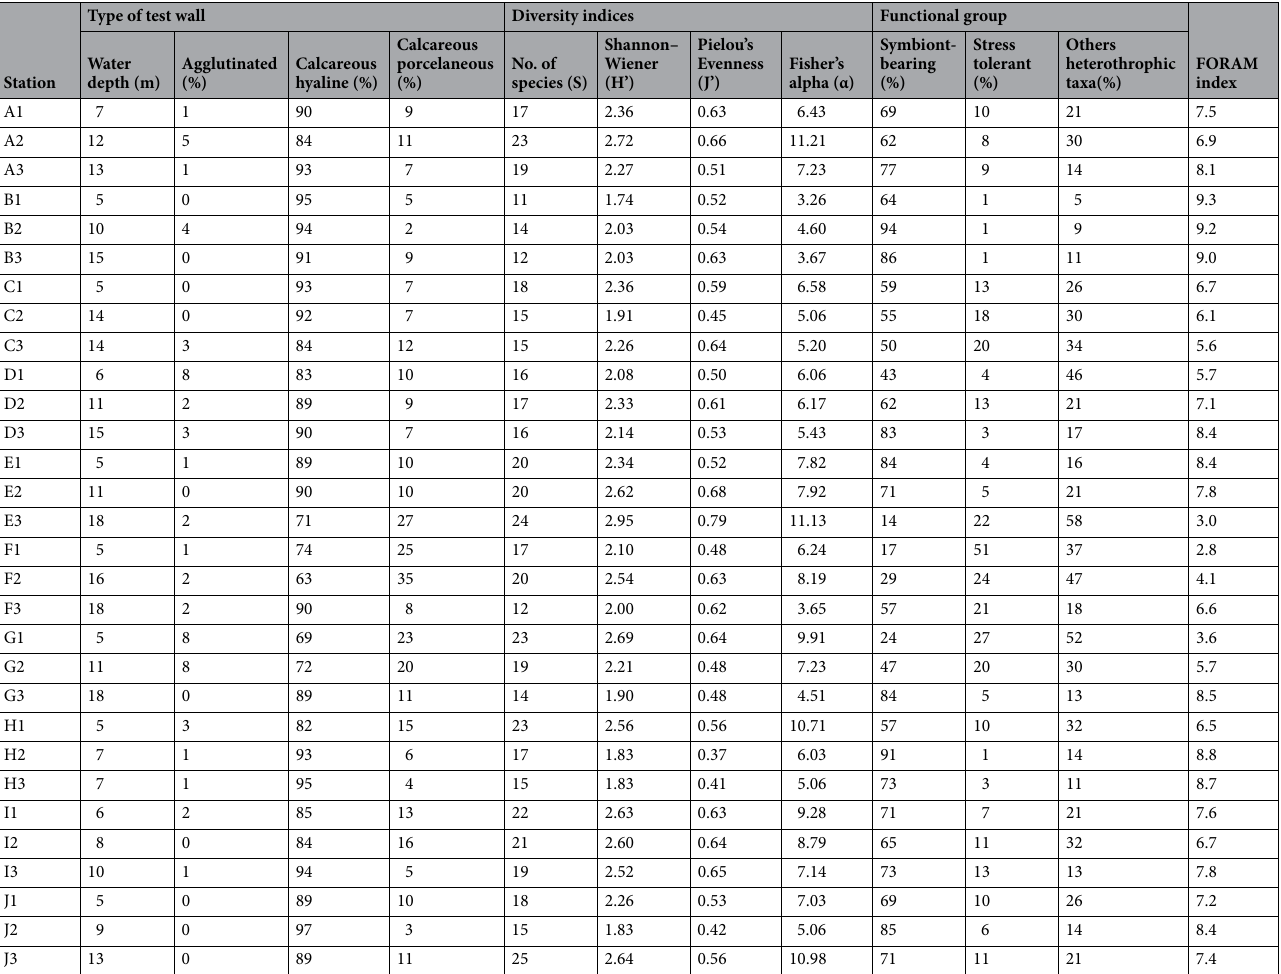
Table 1. Benthic foraminifera distribution in Pulau Tioman presented in type of test wall (agglutinated, calcareous hyaline and calcareous porcelaneous), diversity indices (number of species (S), the